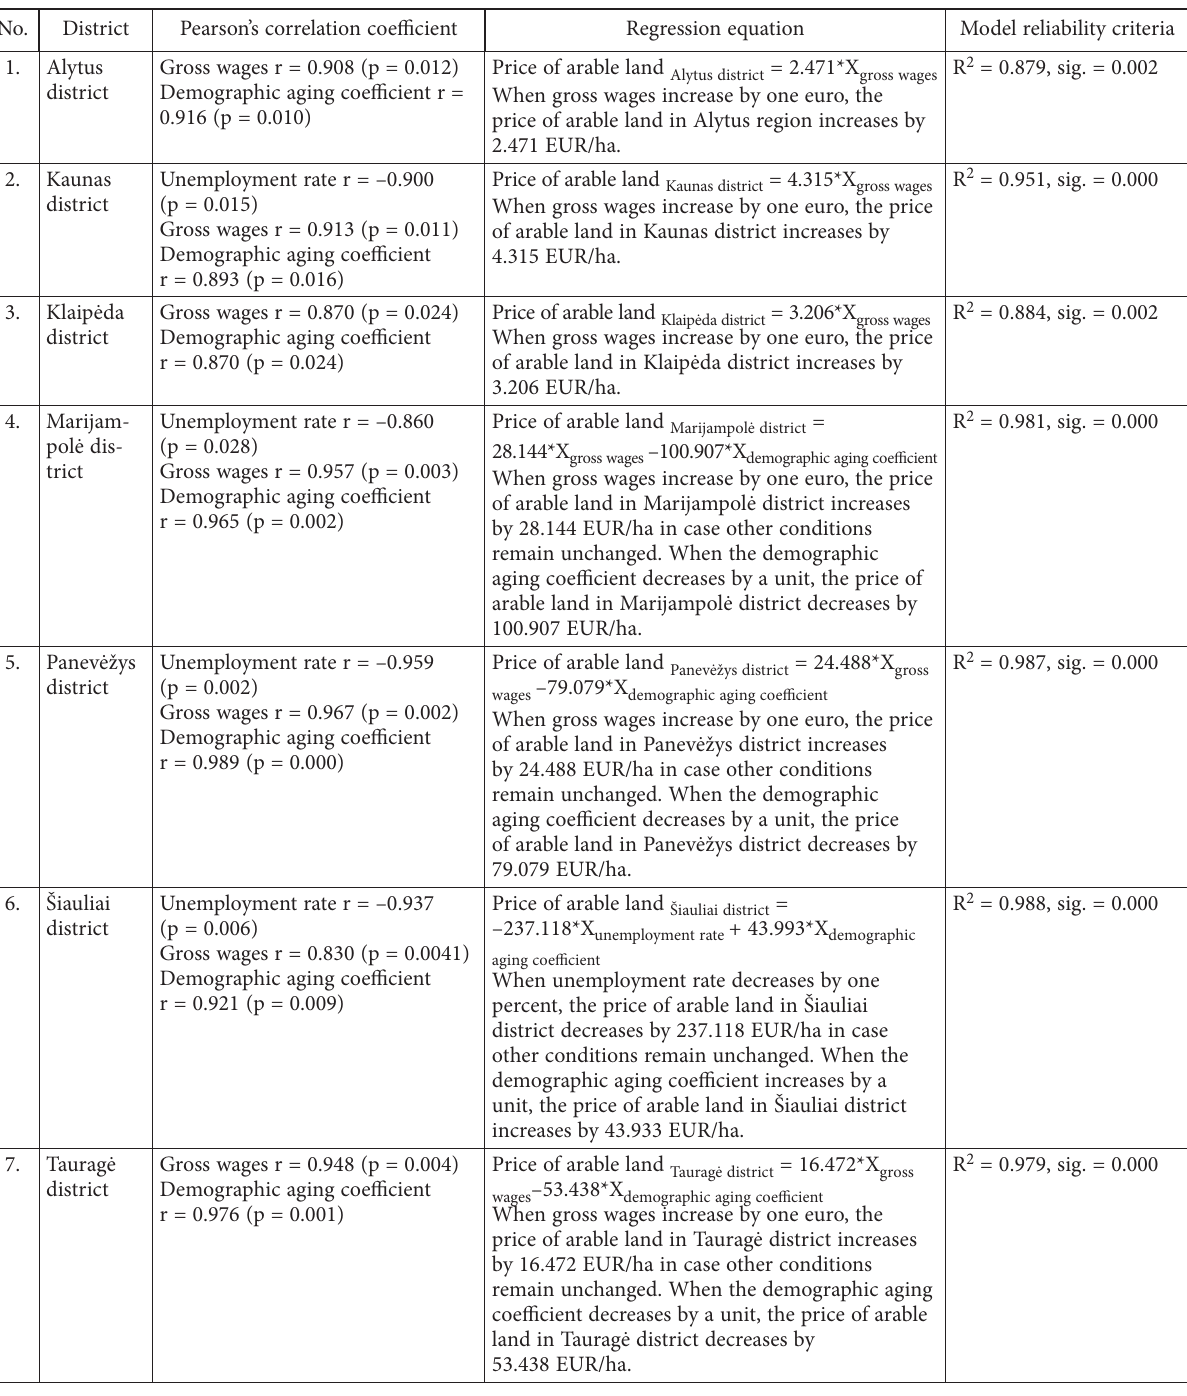
Table A1. Interdependencies between the prices of arable land and gross wages, net migration, unemployment rate and demographic aging coefficient in Lithuanian districts over the period